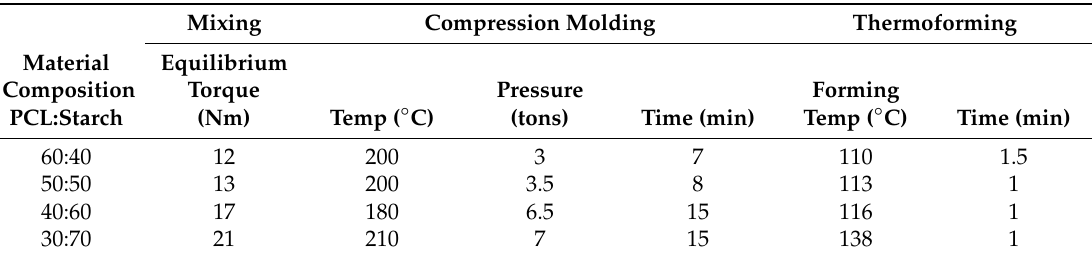
Table 2. Processing conditions for sample preparation.